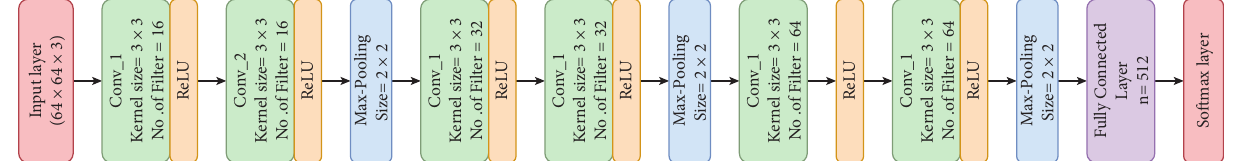
Figure 5: Custom convolutional neural network for classifying civil infrastructure damages.